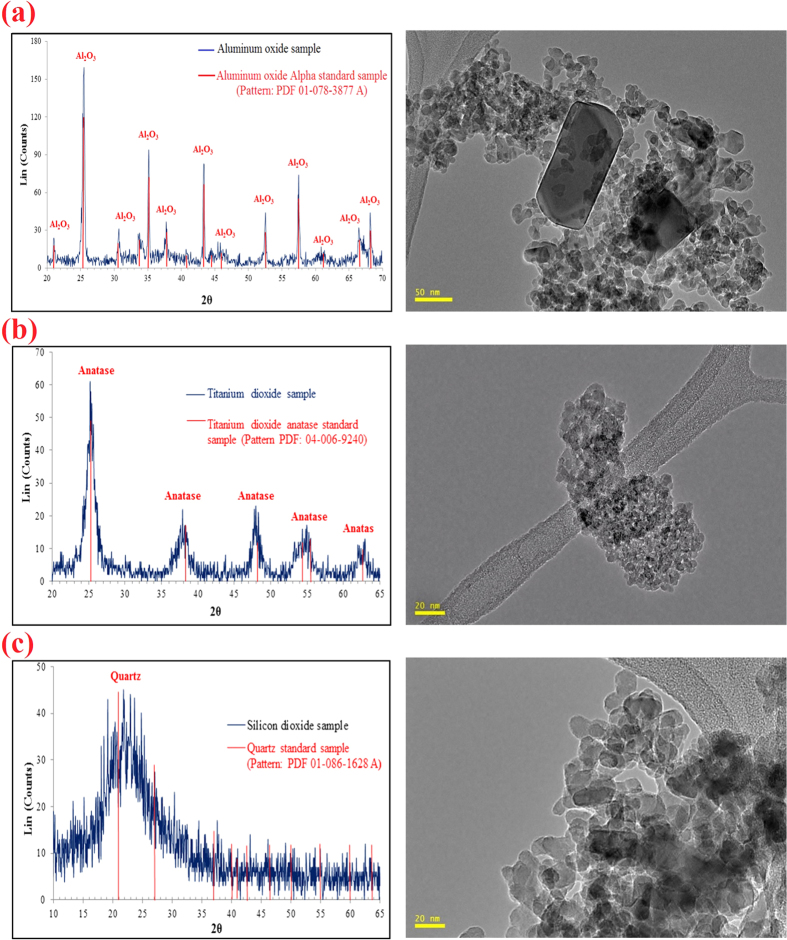
XRD (left) and TEM (right) analyses from the nanopowders (a) Al2O3-NPs, (b) TiO2-NPs, (c) SiO2-NPs.